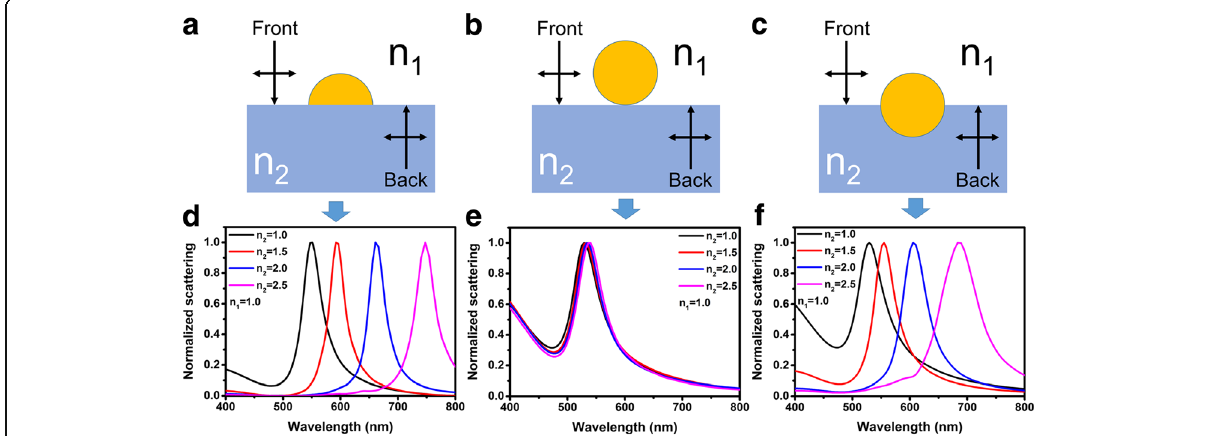
Fig. 1 a – c Schematic diagrams of structure A to C used for FDTD simulations respectively. d – f Normalized scattering spectra of structure A to C with varying substrate refractive indices